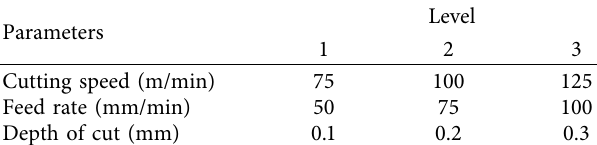
Table 3: Process variables (factors/levels).